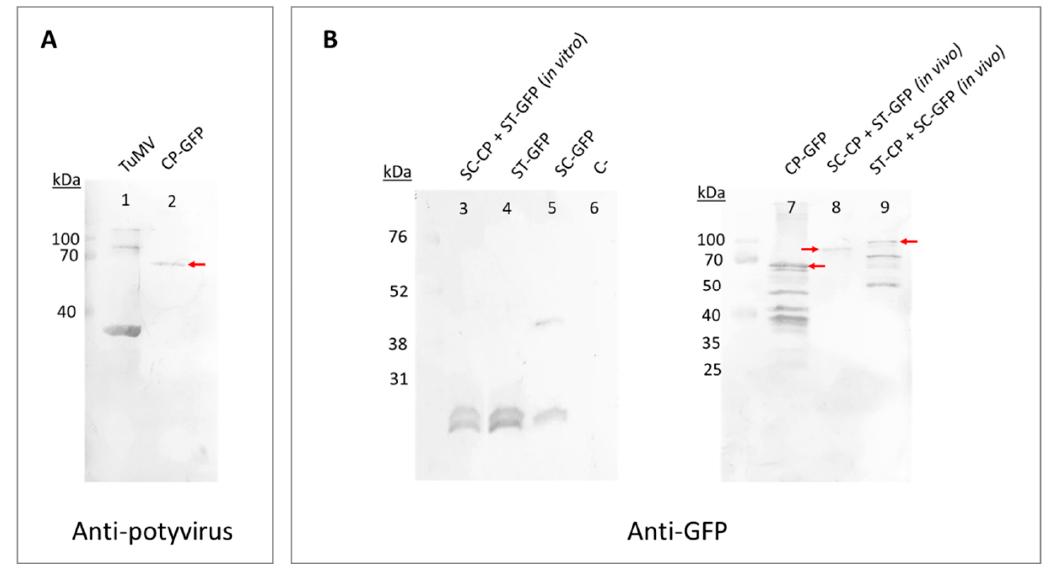
Figure 2. Western blot analyses carried out with the crude extracts of plants infiltrated with the different constructs of VLPs-GFP using the SpyTag/SpyCatcher conjugation technology and genetic fusion. Samples analyzed using anti-potyvirus as the primary antibody are in panel ( A ) and samples analyzed using anti-GFP as the primary antibody are in panel ( B ). For the co-agroinfiltrated con- structs, we specify in parentheses if the reaction took place in the plant (in vivo) or in an Eppendorf tube (in vitro). The red arrows highlight the expected band if SpyTag and SpyCatcher are bound (81.6 kDa for SpyTag-CP + SpyCatcher-GFP, and 75.2 kDa for SpyCatcher-CP + SpyTag-GFP) or if the recombinant protein CP-GFP is produced (61 kDa). ST: SpyTag; SC: SpyCatcher; CP: TuMV capsid protein; GFP: green fluorescent protein; C-: Crude extract from a non-agroinfiltrated Nicotiana benthamiana